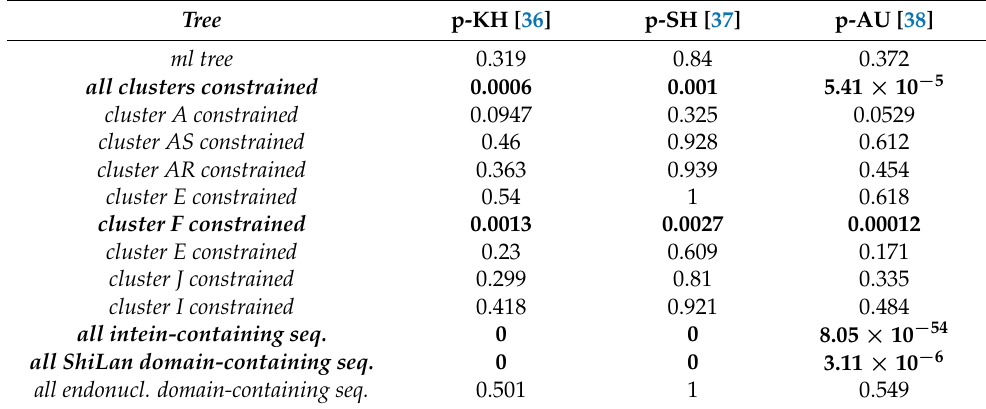
cluster E constrained cluster J